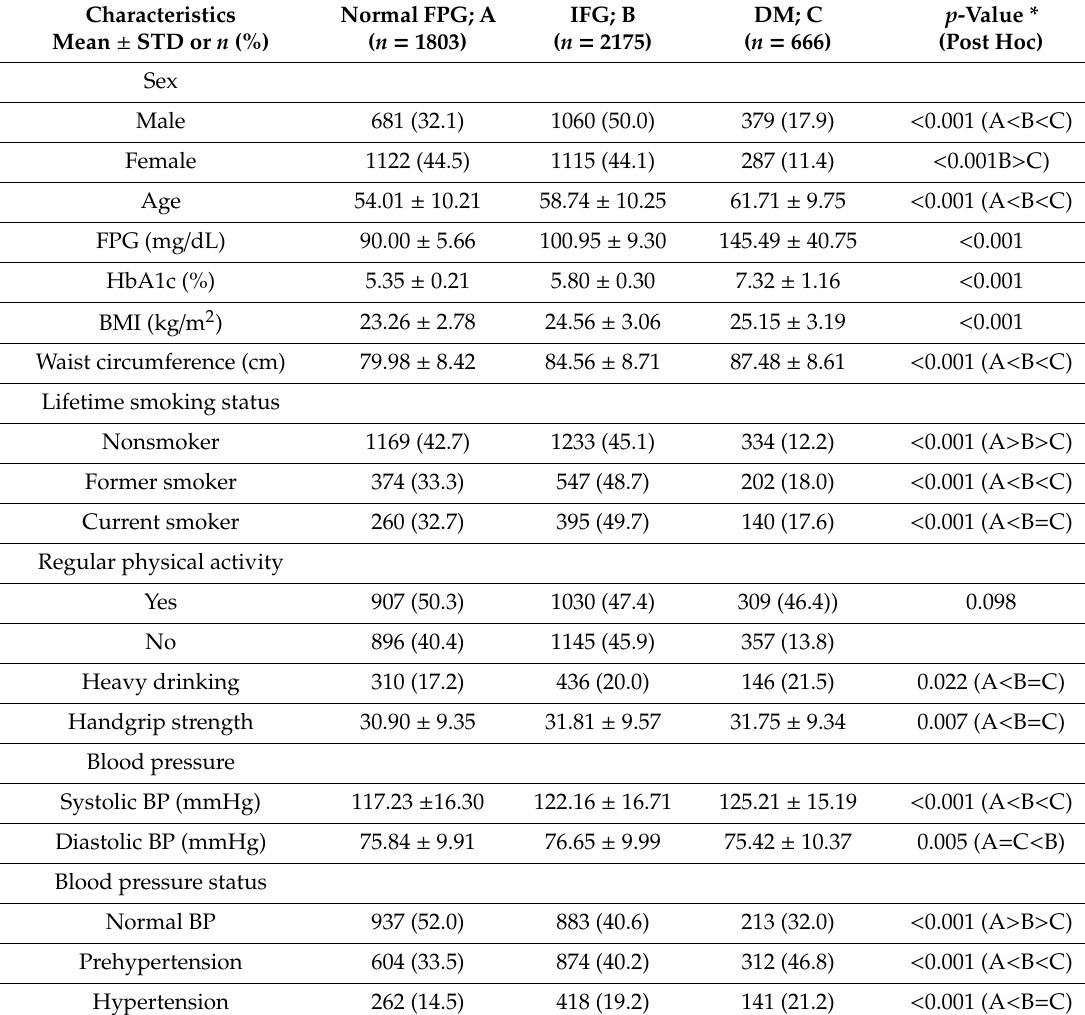
Table 1. The characteristics of the participants stratified by the glycemic